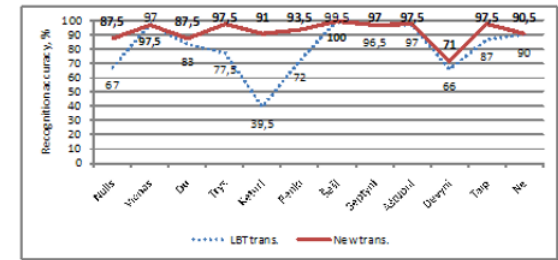
Figure 8. The comparison of the recognition accuracy of the orig- inal LBT transcriptions and the new combinative method based transcriptions